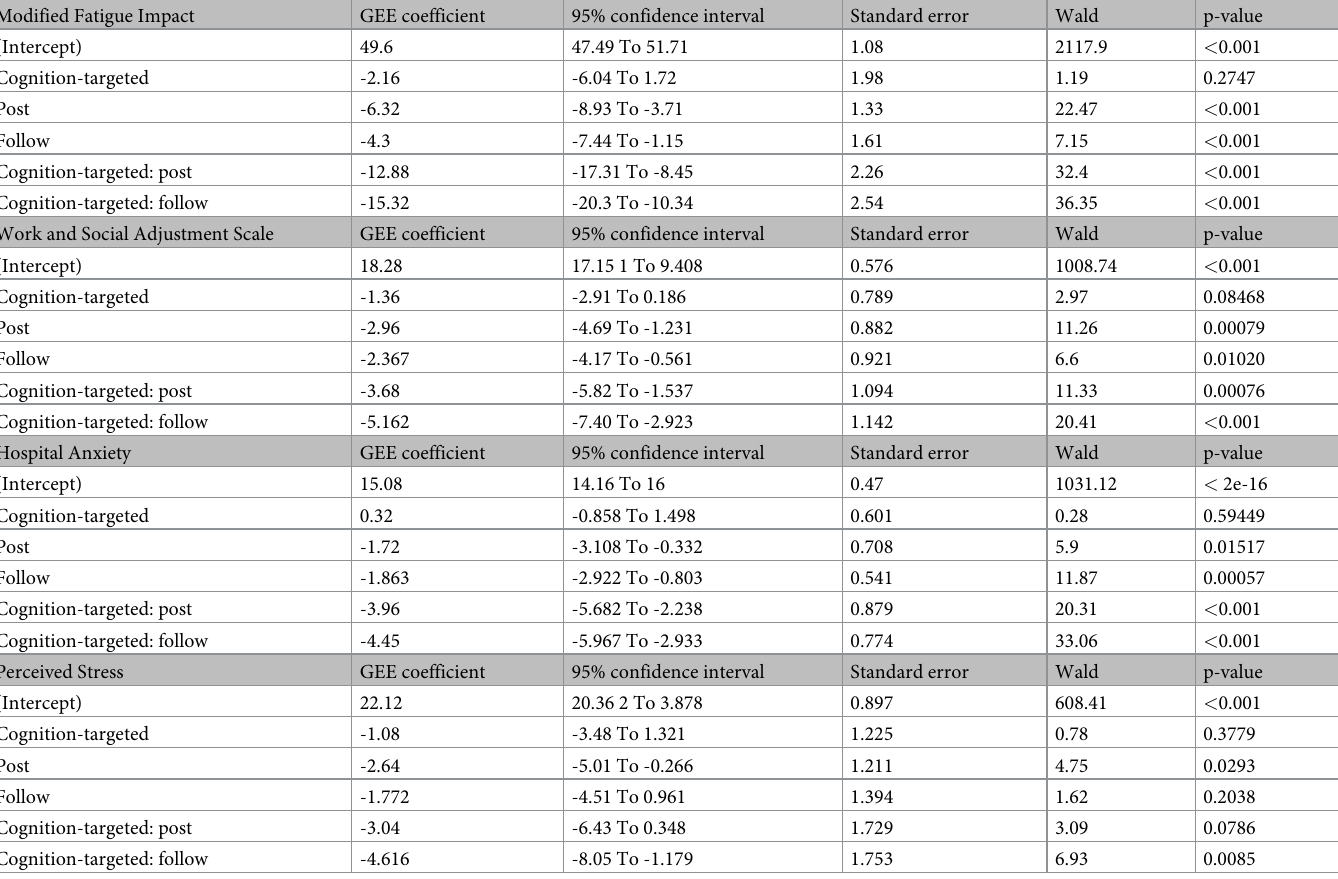
Table 3. GEE model for unit change from baseline to 4- week post treatment and the 3-month follow-up, cognition-targeted. Exercise versus symptom-targeted exer- cise for multiple sclerosis